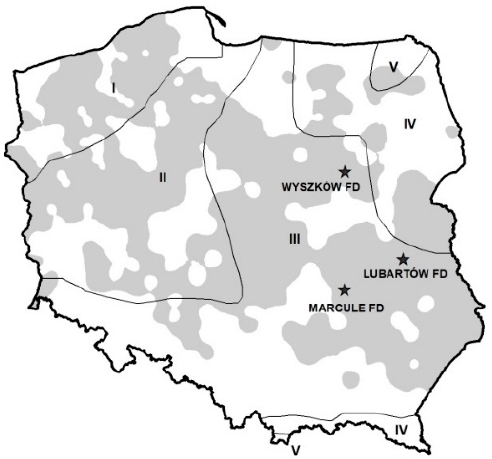
Figure 1. Area of occurrence of Melolonthinae in Poland in 2017 (grey), borders of climatic zones (lines), and locality of experimental plots (stars) in tested forest districts (FD).